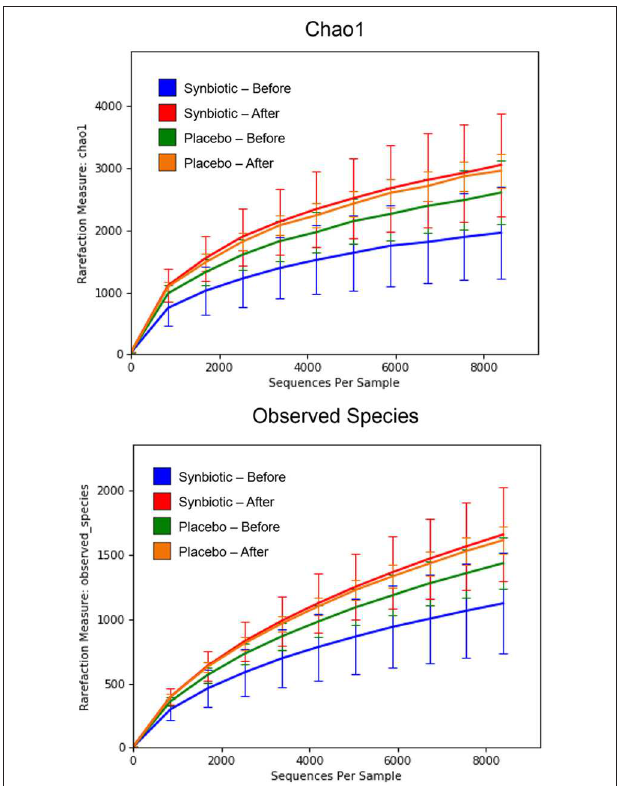
FIGURE 3 | Rarefaction plot of fecal bacterial species from dogs with food-responsive chronic enteropathy. Data shown are from before and 6 weeks after a change to a hydrolyzed protein diet as a sole food, supplemented with either a synbiotic or a placebo, and expressed by the Chao 1 diversity index (Upper) and the number of observed bacterial species (Lower) .